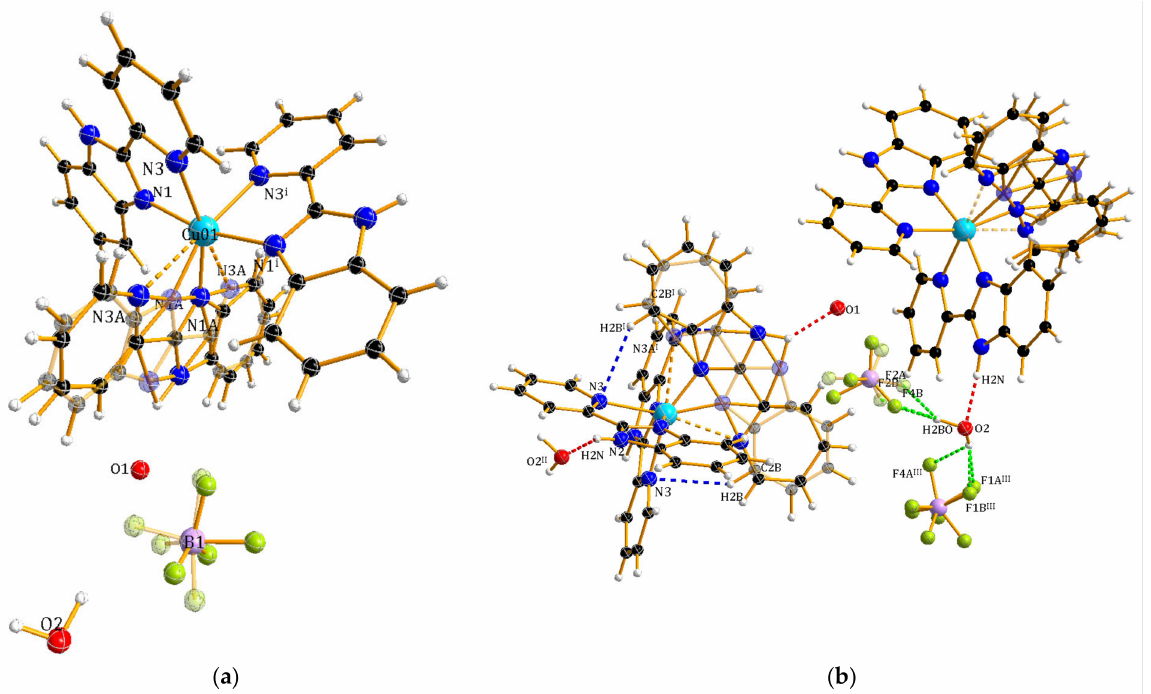
Figure 4. ( a ) Molecular structure of [Cu(pyBIm) 3 ](BF 4 ) 2 · 1.5H 2 O ( 4 ) and ( b ) selected intra- and intermolecular H-bonding